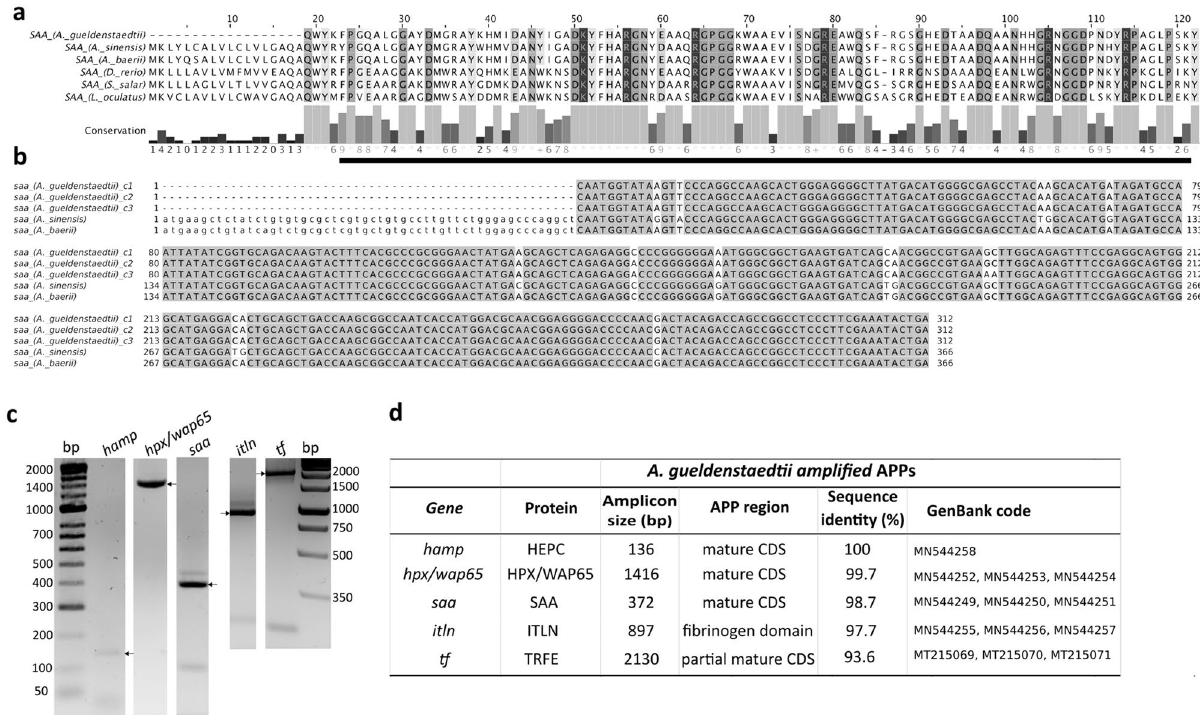
Figure 1. Teleost and sturgeon SAA alignment. ( a ) Amino acid sequence alignment of mature SAA from A. gueldenstaedtii (Russian sturgeon , consensus sequence), A. sinensis (Chinese sturgeon , translated using GenBank ID GETX01015093.1), A. baerii (Siberian sturgeon , translated from the transcript comp122687_ c0_seq1 58 ), D. rerio (Zebrafish , UniProtKB Q642J9), S. salar , (Atlantic salmon, UniProtKB B9EPA2) and L. oculatus (Spotted Gar , UniProtKB W5MIJ6) using Clustal Omega. Sequence identity is shown in gray scale and the specific SAA domain (Pfam 00,277) is underlined in black. ( b ) Nucleotide alignment of saa from A. gueldenstaedtii (clones c1-c3, GenBank IDs: MN544249, MN544250 and MN544251, without the leader sequence), with the entire saa coding sequences from A. sinensis (GenBank ID GETX01015093.1) and A. baerii (comp122687_c0_seq1 58 ), using Clustal Omega. The leader sequence is shown in lower case letters and the sequence identity is represented in shades of grey. ( c ) Analysis by agarose gel electrophoresis of RT-PCR products corresponding to A. gueldenstaedtii hamp, hpx/wap65 , saa , itln and tf amplicons, showing the expected amplicon size as indicated by black arrows. RT-PCR products were run on agarose gels (1.5%) in parallel with the Mw marker. For a better illustration, gel images were cropped from full gels and aligned using the Mw marker as a reference. The original gels are shown in Supplementary Figure S12. ( d ) A. gueldenstaedtii amplified products: the table shows the expected amplicon size, the APP region, the percentage of identity of each